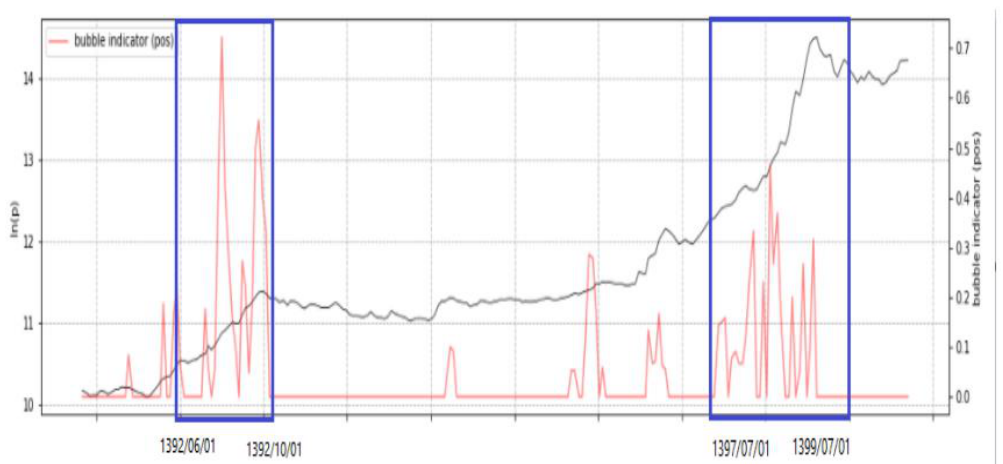
Figure 4, long term indicator of